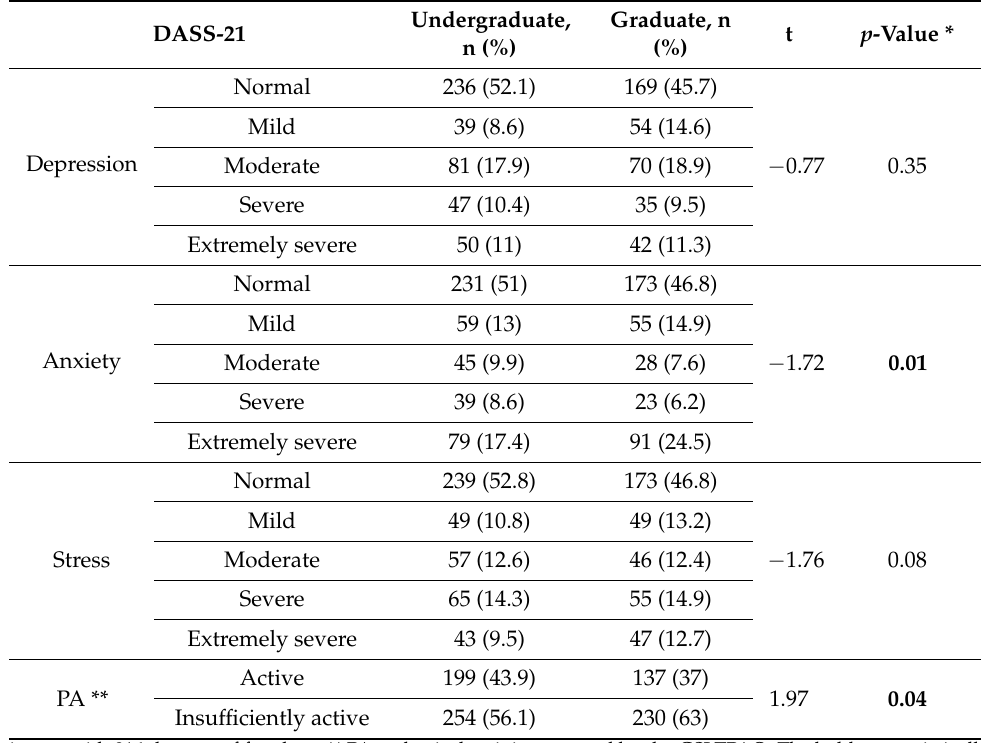
Table 10. The prevalence of the categories of depressive, anxiety, and stress symptoms according to the DASS-21 and GSLTPAQ. Groups are divided by study program (N = 823). DASS-21